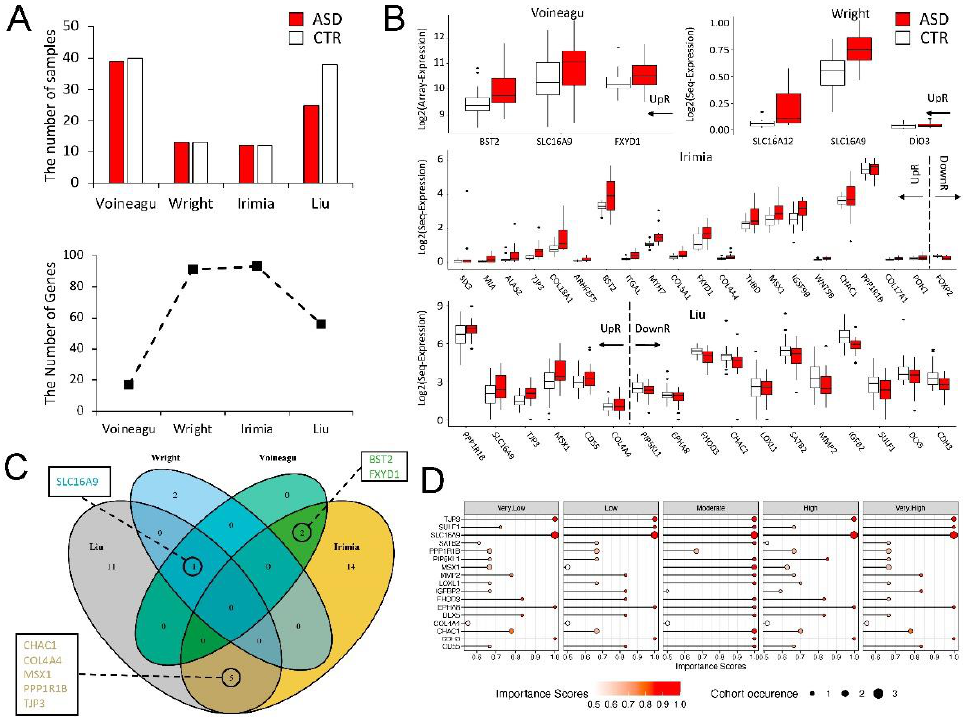
Figure 3. Multiple DEGs in the hippocampi of SD mice are identified as ASD risk genes in four published studies. ( A ) Top panel bar plot shows the number of ASD and CTR samples in each of the four published cohorts; bottom panel line plot shows the number of mouse-model-identified DEGs that also measured the expression in the cohort. ( B ) Boxplots show the expression values of overlapped DEGs between mouse models and each cohort (mice-cohort DEGs). There are 3, 3, 21, and 17 SD mice DEGs that are also differentially expressed in the cohort data of Voineagu et al., Wright et al., Irimia et al., and Liu et al., respectively. The genes in the boxplot are ordered by the Log2FC values. ( C ) Venn diagram shows the overlapping genes between mouse-cohort DEGs. We highlight that SLC16A9 is identified in three cohorts, and that CHAC1, COL4A4, MSX1, PPP1R1B, TJP3, BST2, FXYD1 are identified in two cohorts. ( D ) Dot plots show the importance score of genes for each ADI-R class in the data of Liu et al. The importance scores are calculated from the learning vector quantization model and are characterized as: Very Low, Low, Moderate, High, Very High, each corresponding to the low, moderate2, moderate1, high2, and high1 ADI-R classes in the original paper, respectively. The larger the importance score, the more the importance of the gene to predicting the ADI-R class. The size of the dot represents the occurrence of the gene in different cohorts.